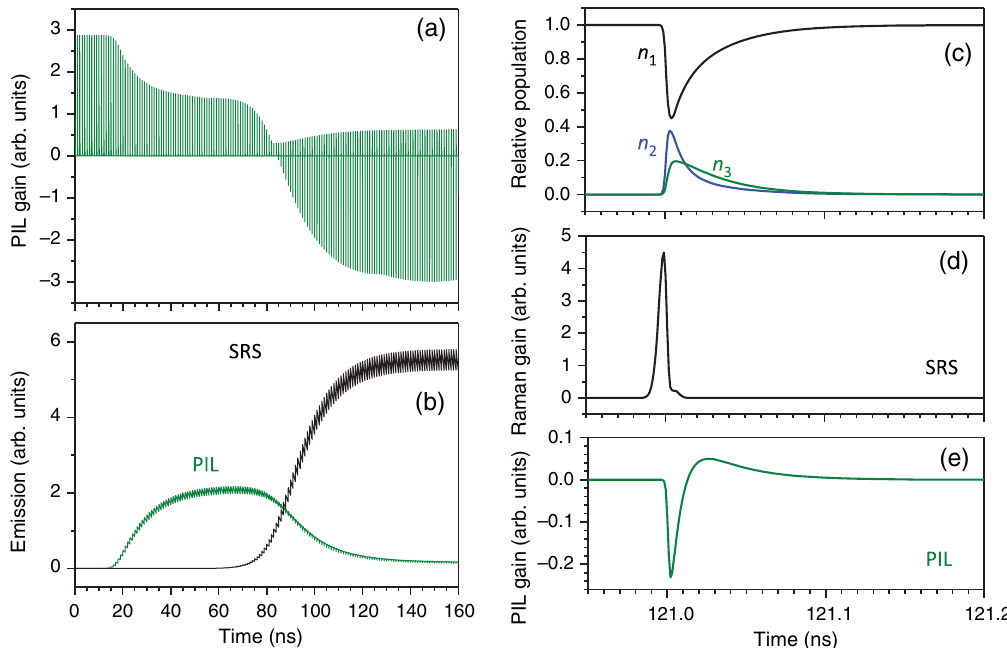
FIG. 5. Simulated laser pulse dynamics of a three-level system under pulsed FEL excitation at the front of the macropulse: (a) Evolution of the PIL gain; (b) separate outputs of the PIL and SRS lasing. Evolution on the micropulse timescale: (c) relative populations of the states, (d) SRS gain, (e) PIL gain. The parameters of the model: pump rate R 13 is 10 11 s − 1 ; the relaxation rate W 32 between the upper 2 p state and the intermediate 1 s ð E Þ state is 2 × 10 10 s − 1 and W 21 between the 1 s ð E Þ and the 1 s ð A 1 Þ ground state is (cid:2) 10 11 s − 1 ; direct relaxation from the upper into the ground state ( j 3 i → j 1 i ) is neglected; losses at the Si ∶ Bi emission frequency are 10 10 s − 1 . Note that developing Raman emission competes with the PIL and causes a specific step in the output power (for details see the Supplemental Material